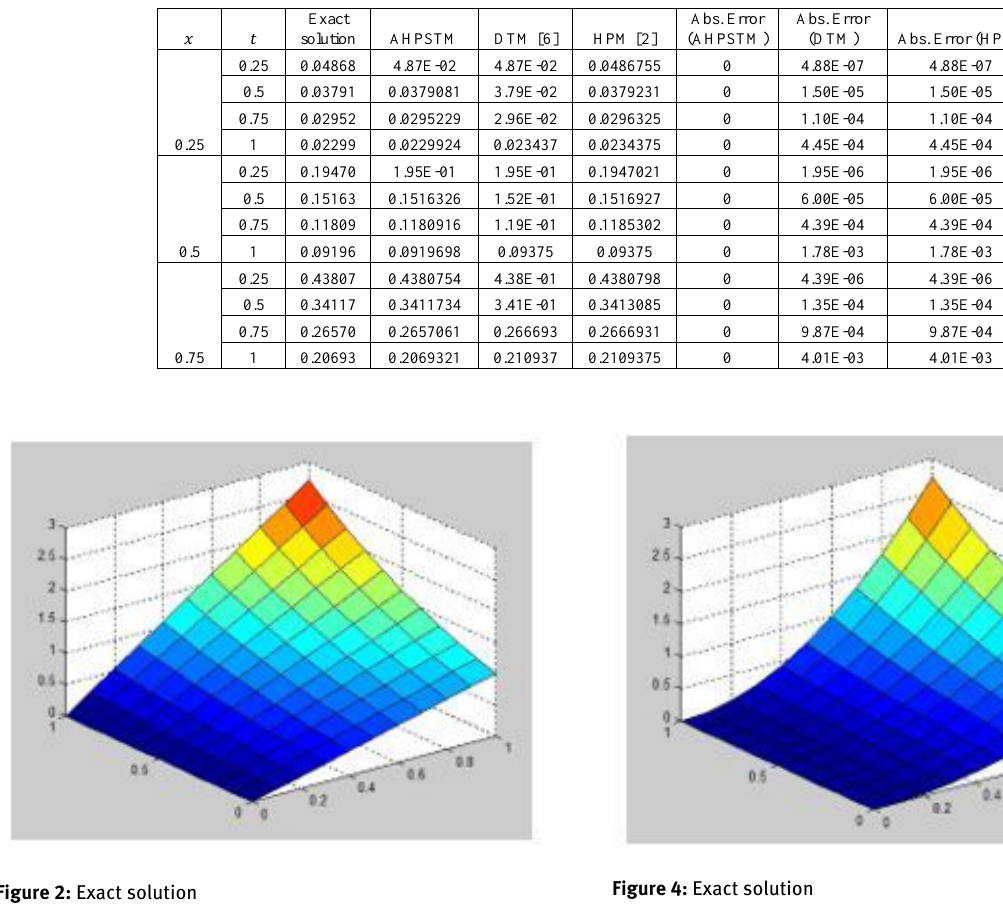
Figure 2: Exact solution